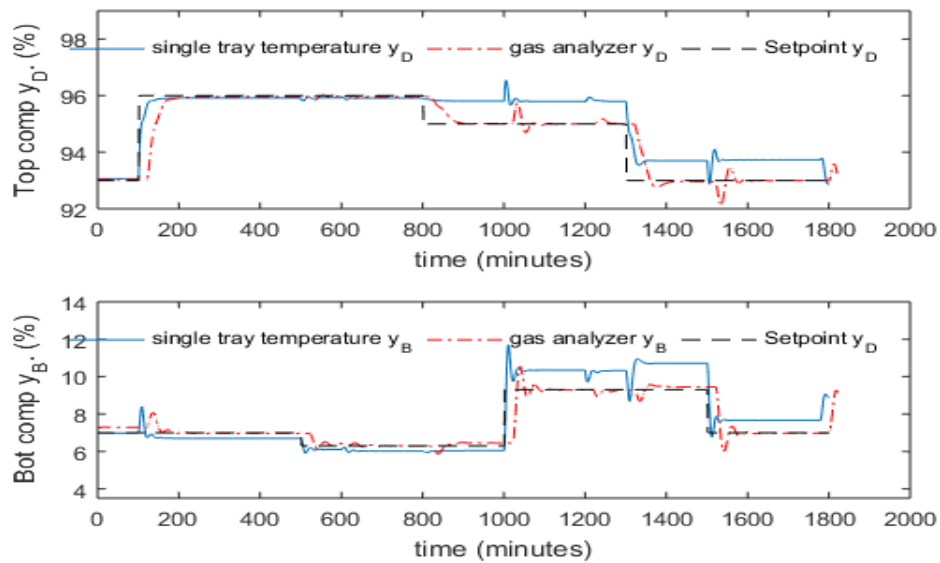
Figure 10. Control performance of tray temperature control and composition analyzer-based con- trol.